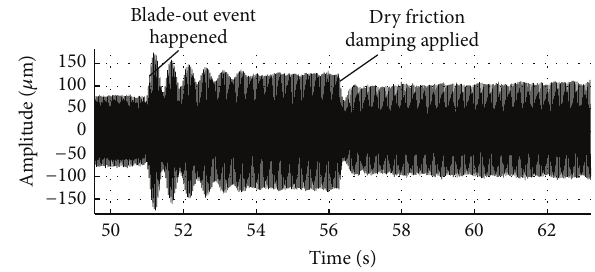
Figure 16: The contrast of Bode curves of the rotor system by two damping applied methods (CH1).